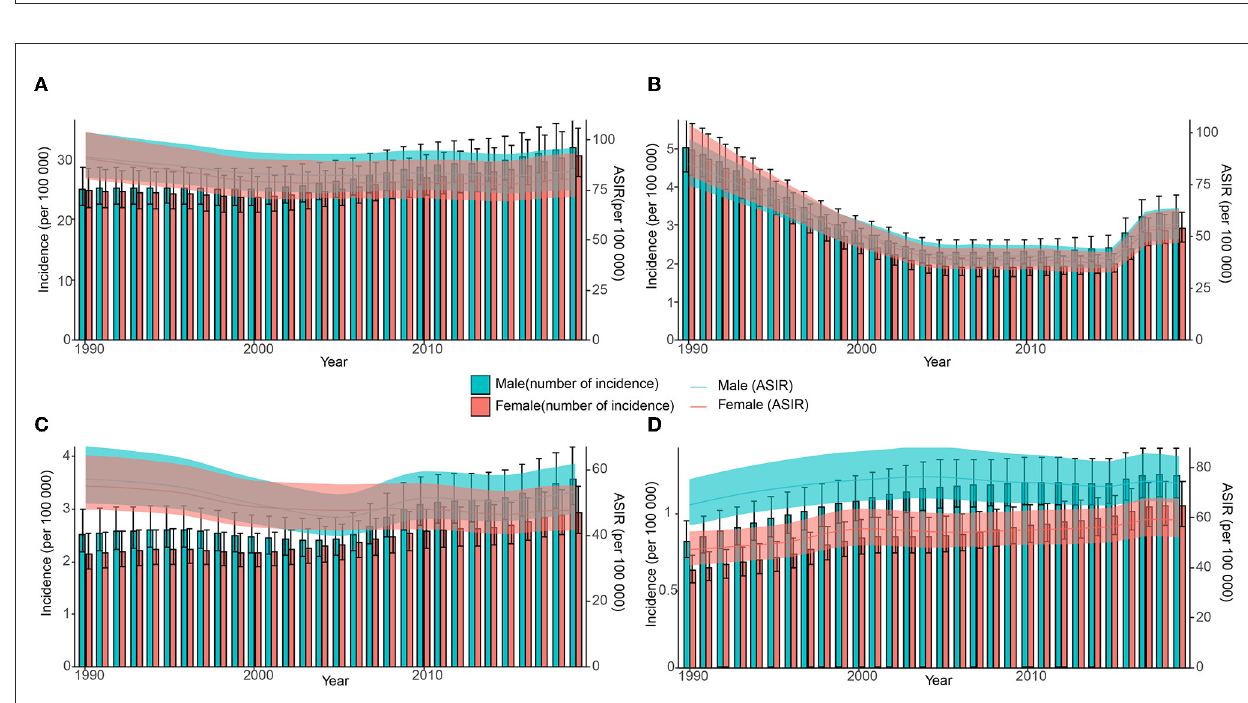
FIGURE4 Number and age-standardized rate of incidence with 95% uncertainty intervals (UIs) in different regions, 1990–2019. (A) Global; (B) China; (C) India; (D) the United States.